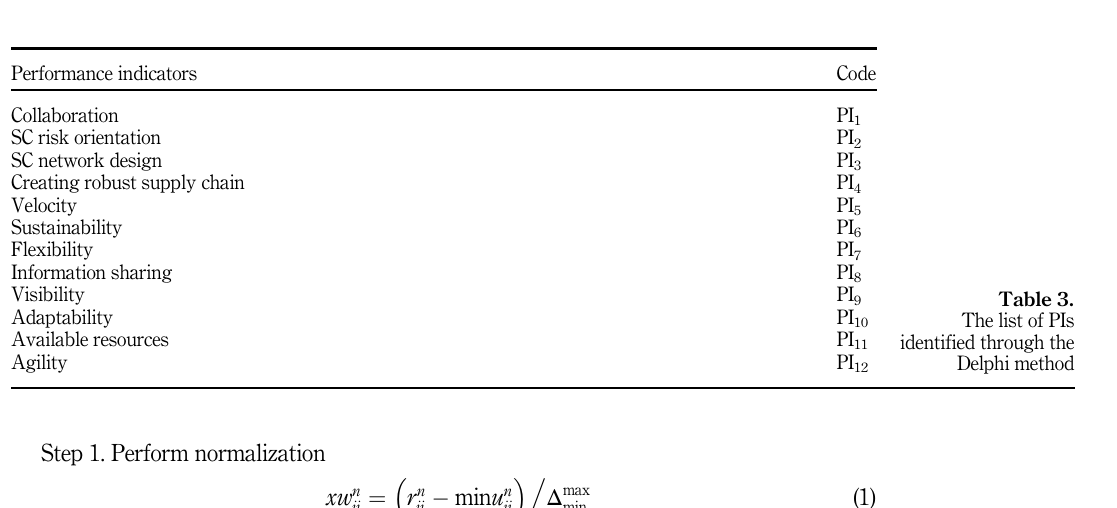
Table 2. Profile of case